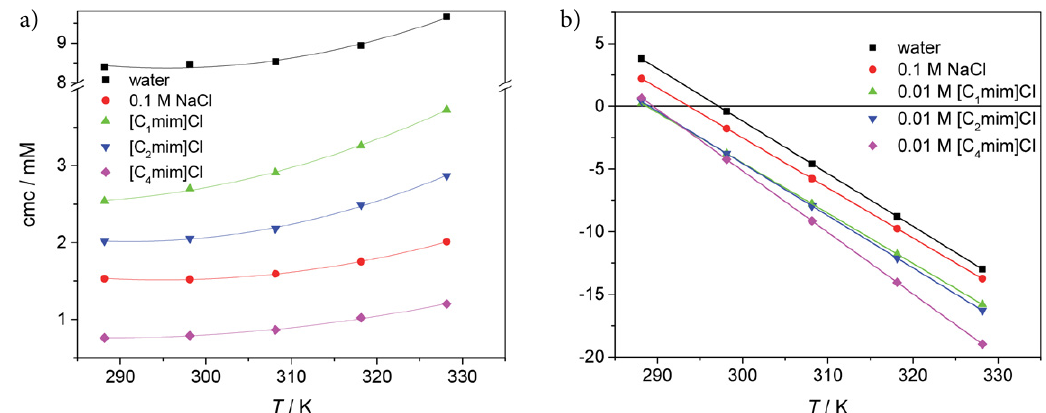
Figure 2. (a) The values of cmc and (b) ∆ M H o as a function of temperature for all investigated systems. Lines in (a) present guides to the eye (poly- nomial fits) and in (b) linear fits from which the heat capacities of micellization were